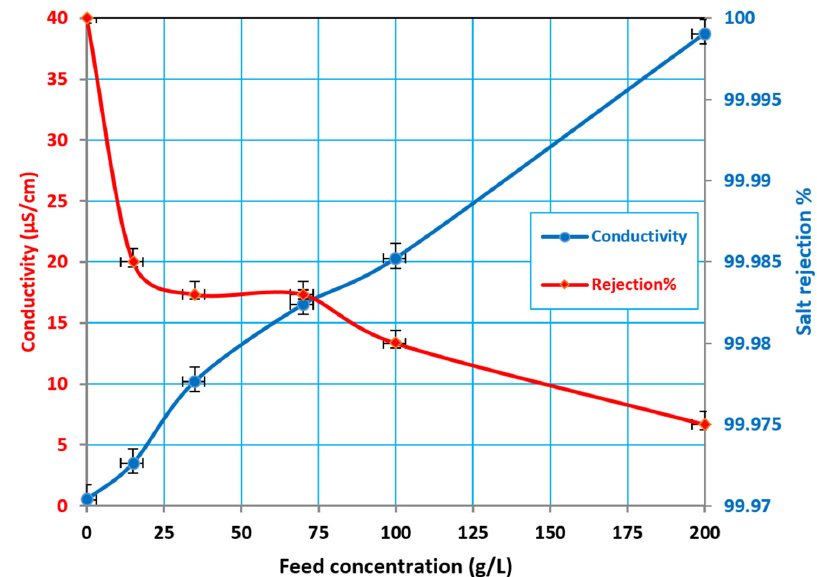
Figure 7. Impact of the NaCl concentration on the conductivity and salt rejection at 60 °C feed temperature and a feed flow rate of 1.07 L/min.